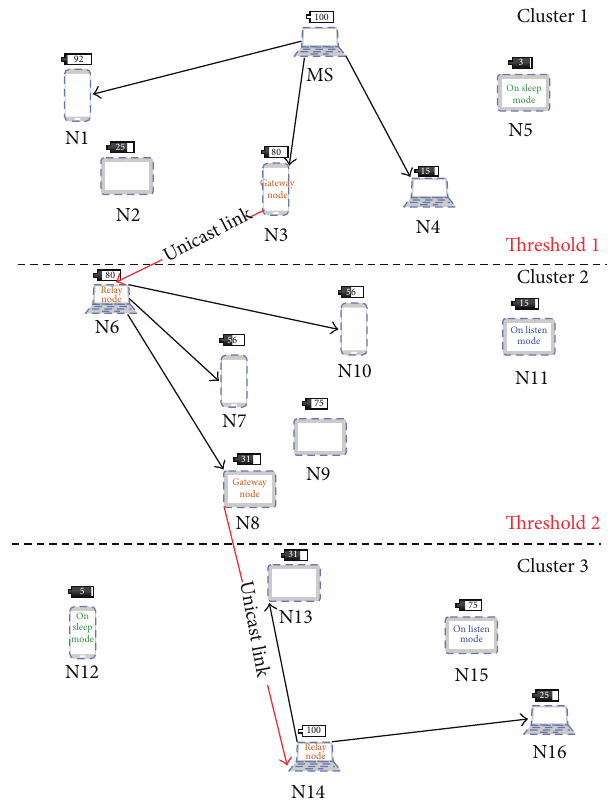
Figure 4: Multicast flow adjustment in our REEDDRE.